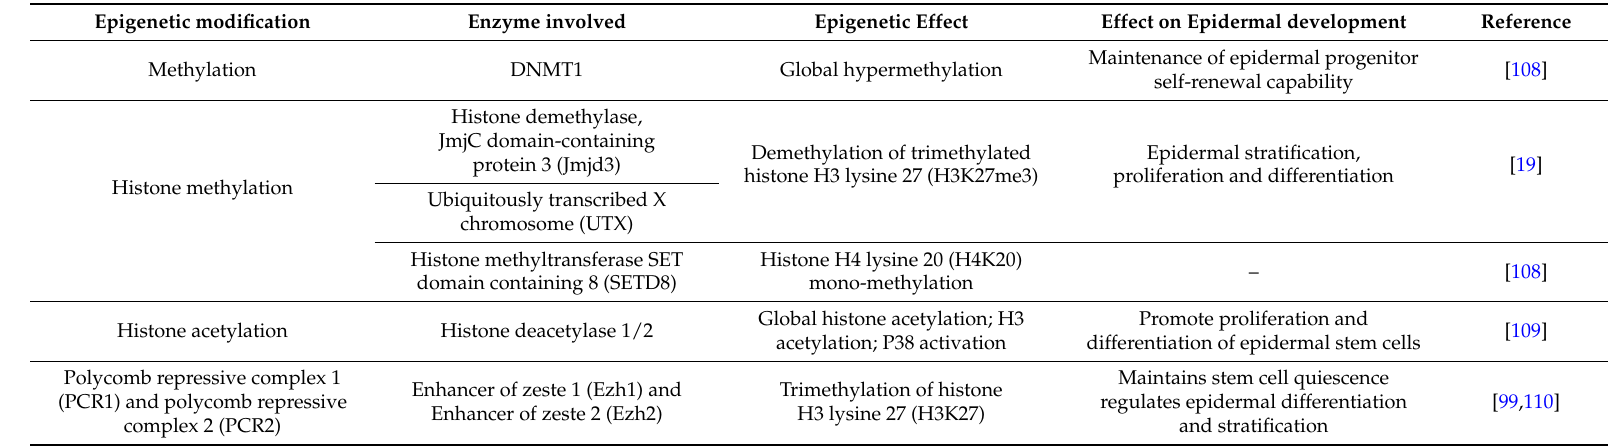
Table 3. Epigenetic regulation of epidermal stratification in wound